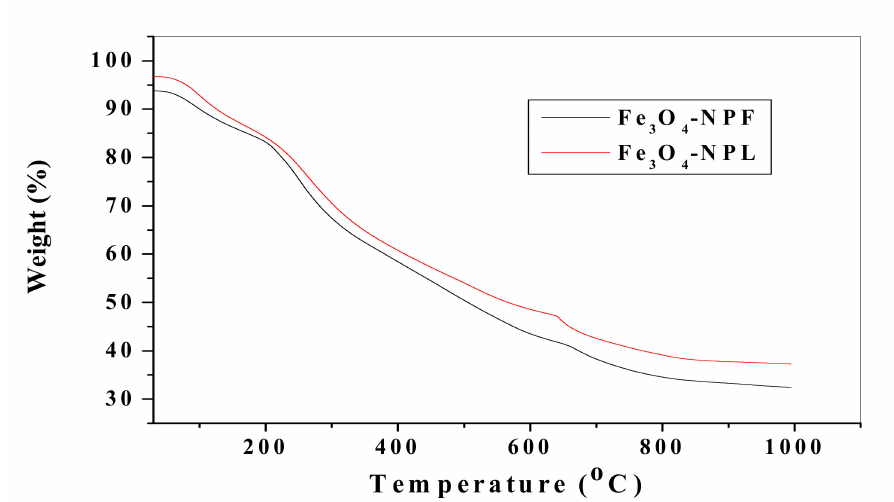
Figure 9. Thermogravimetric curves of Fe 3 O 4 -NPs from C. viminalis leaf and flower extracts.